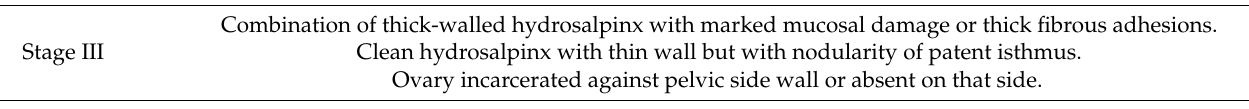
Table 1. Winston and Margara staging system of tubal disease [23]. Thin-walled hydrosalpinx with little or no fibrosis. Mucosa thrown into folds with no flattened areas. Stage I Adhesions (if present) flimsy and limited to the ampulla and ovary only. Ovary present and mainly free. Thick-walled hydrosalpinx with good mucosa. Mucosa flattened with attenuated or few folds but thin-walled areas. Stage II Mucosal fold markedly adherent in lumen. Fibrous thick adhesions involving tube and/or ovary. Ovary present and mainly free. Combination of thick-walled hydrosalpinx with marked mucosal damage or thick fibrous adhesions. Stage III Clean hydrosalpinx with thin wall but with nodularity of patent isthmus. Ovary incarcerated against pelvic side wall or absent on that side. Stage IV Tubo-ovarian mass or fibrous, adherent hydrosalpinx with incarcerated ovary and/or isthmic damage.